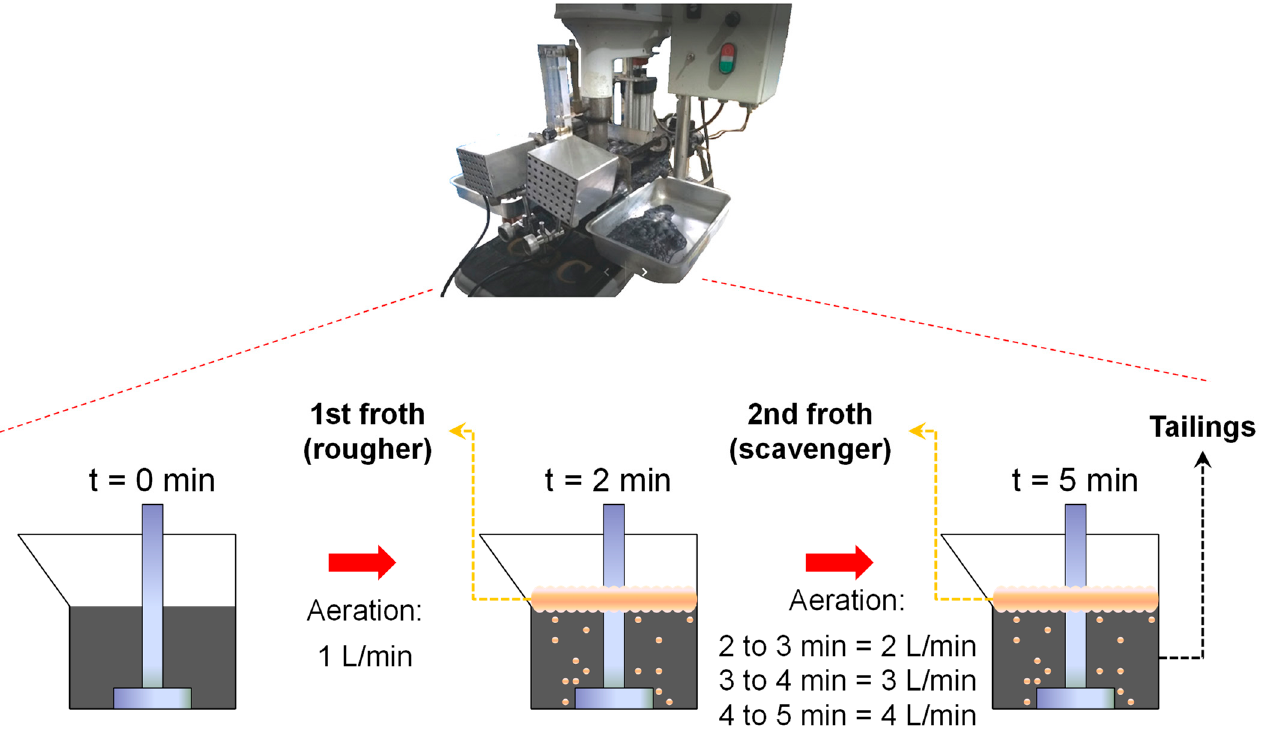
Figure 4. Flotation equipment and scheme of flotation testing procedures.